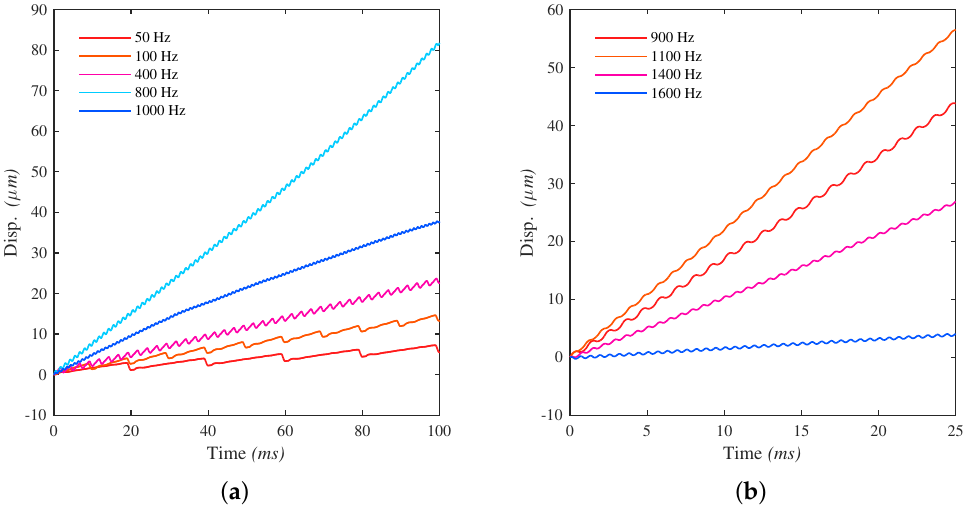
Figure 11. The output displacements at different frequencies driven by waveform: ( a ) STW; ( b )